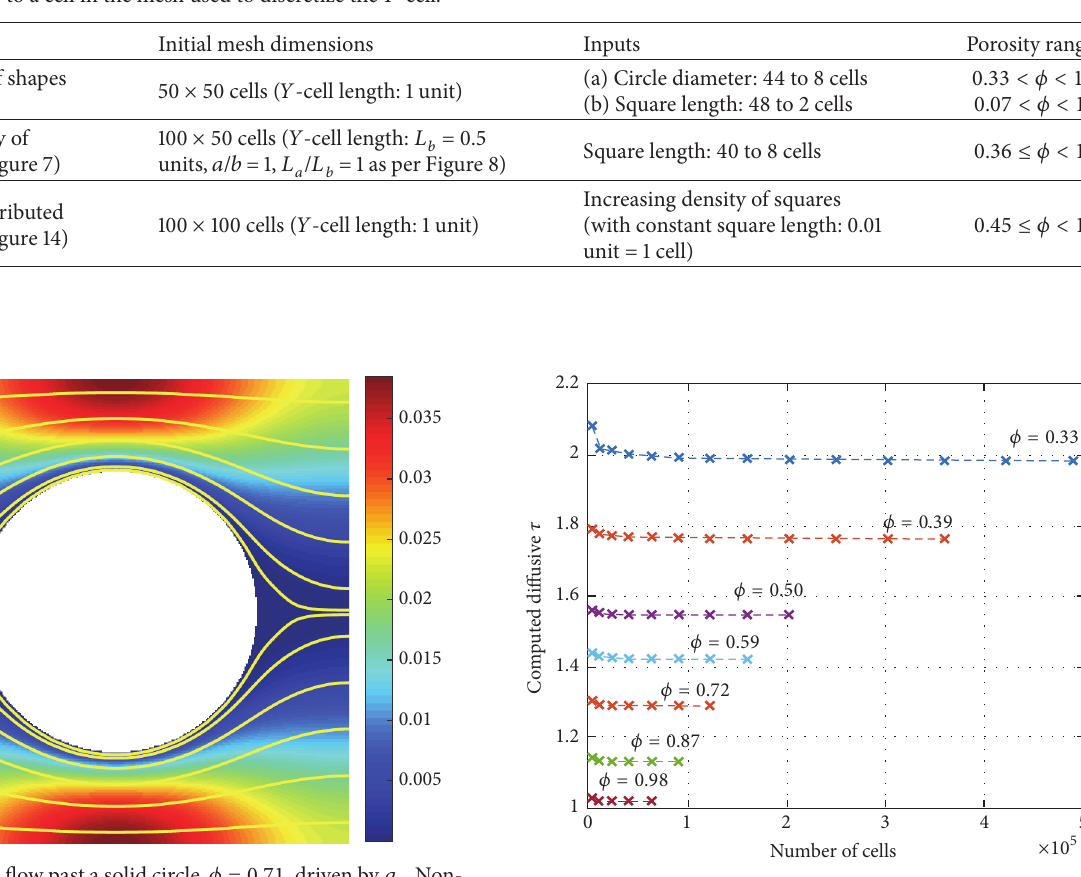
Table 4: Input parameters used to generate different pore-geometries (or different 𝑌 -cells) and their corresponding porosity ranges. In this table, cell refers to a cell in the mesh used to discretize the 𝑌 -cell.